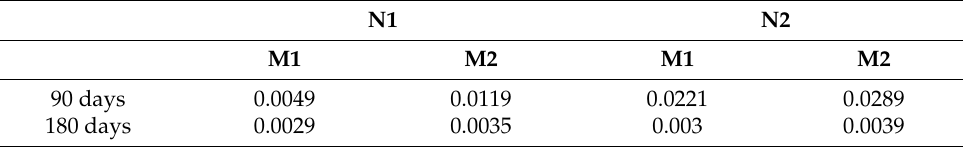
Table 3. RMS of the predicted data based on ANN model with respect to the virtual experimental